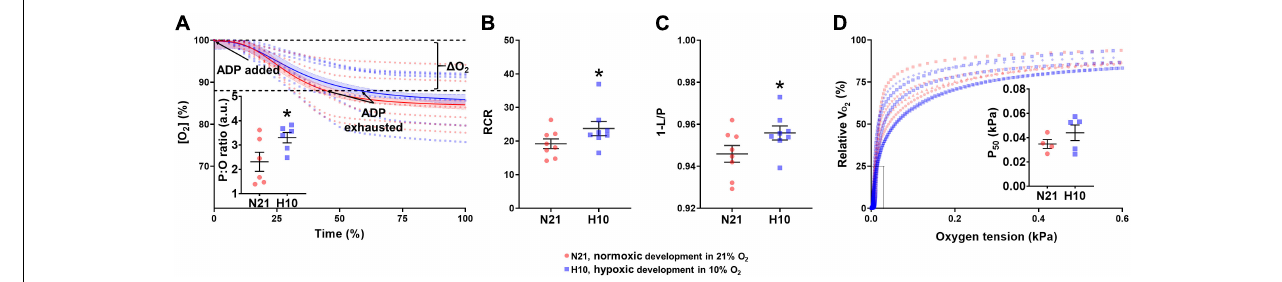
FIGURE 5 | Mitochondrial efficiency of ATP production and O 2 affinity in juvenile snapping turtles from normoxic (21% O 2 ; N21) and hypoxic (10% O 2 ; H10) incubations. (A) P:O ratio. Oxygen concentration as a function of time is shown for normoxic ( n = 5) and hypoxic ( n = 5) developmental groups. Solid lines correspond to the line of best-fit. The inset graph shows the mean P:O values ( ± SEM). (B) The respiratory-control ratio (RCR) and (C) OXPHOS coupling efficiency ratio were calculated for normoxic ( n = 5–8) and hypoxic ( n = 5–8) developmental groups. Both ratios were measured in the presence of complex-I subtrastes. ) as a function of oxygen concentration is shown, with individual curves plotted for normoxic ( n = 5) and (D) Mitochondrial oxygen affinity. Respiration rate ( V O 2 hypoxic ( n = 5) incubation. The inset graph shows the mean P 50 values ± SEM. Calculations for all variables are given in Section “Materials and Methods.” Statistical significance was assessed with individual generalized linear models, followed by Sidak post hoc tests, to assess the effect of developmental O 2 (N21 vs. H10). Values were considered significant when P ≤ 0.05, which are denoted by asterisks